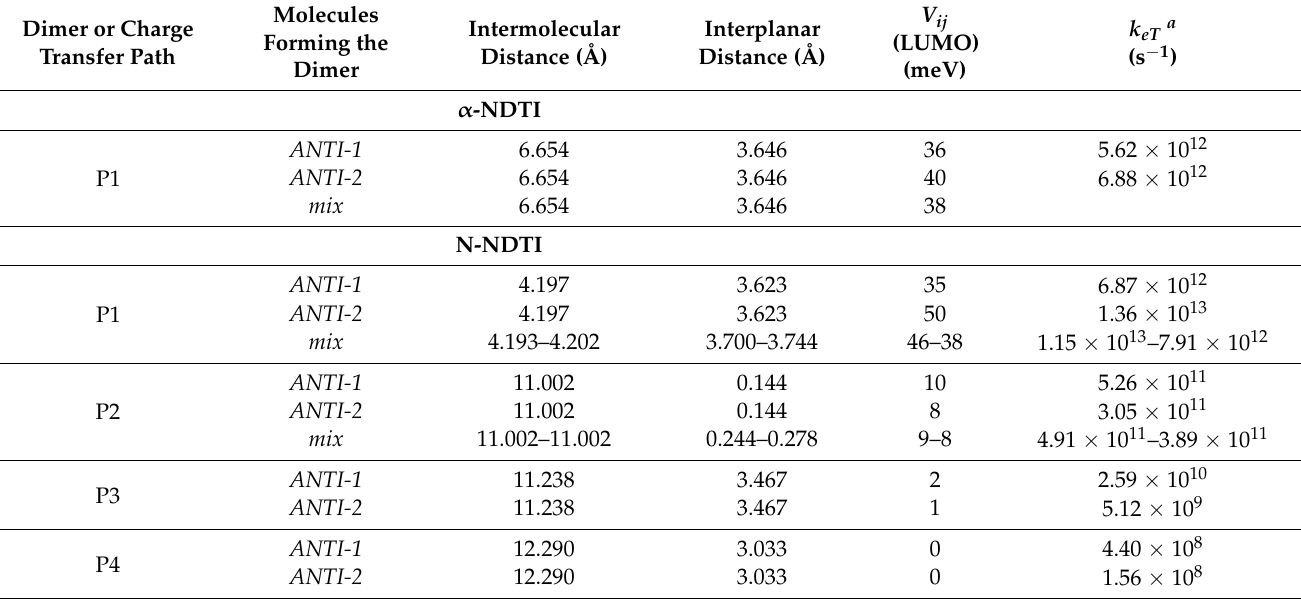
Table 1. Charge hopping paths (Pn) relevant for charge transport and the intermolecular distances for each dimer, inter- planar distances, and electronic couplings V ij (B3LYP/6-31G*) between the LUMO orbitals and Marcus-Levich-Jortner (MLJ) rate constants k eT computed for three crystalline structures ANTI-1 , ANTI-2 , and mix of α -NDTI and N-NDTI